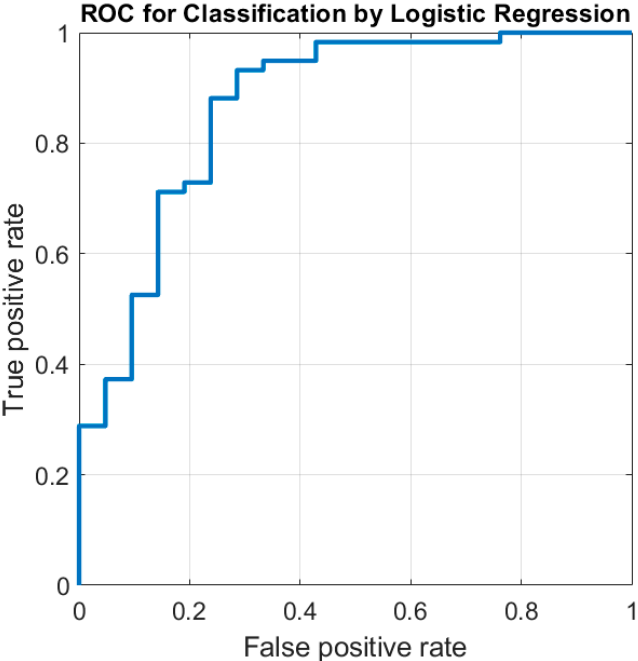
Figure 1. Receiver-operating characteristic (ROC) curves for predicting human papillomavirus (HPV) status of oropharyngeal squamous cell carcinoma. The AUC was 0.87 [95%CI 0.73–0.95].